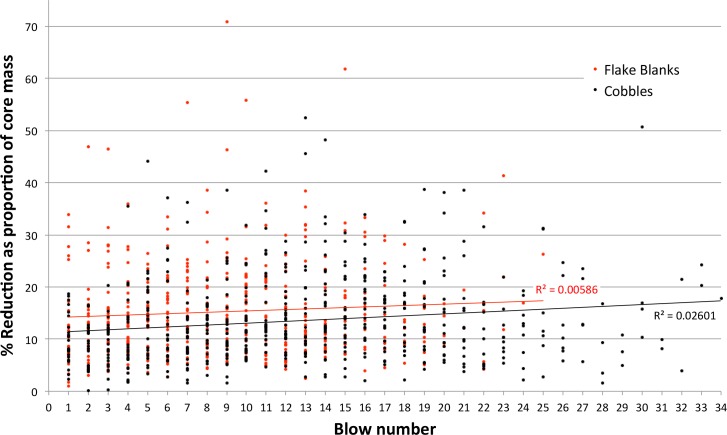
Scatterplot showing the decrease in individual core mass caused by the removal of a flake, relative to reduction interval (blow number).